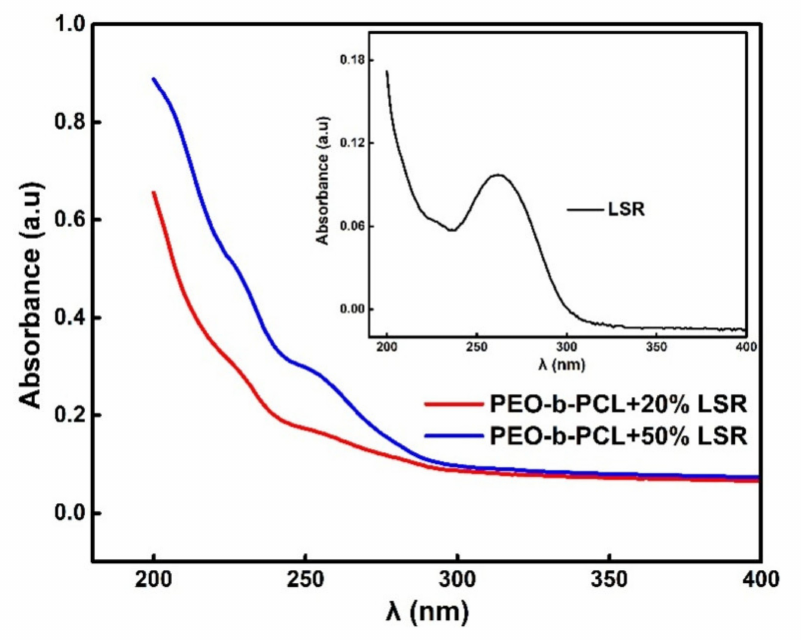
Figure 4. Comparison of UV-Vis spectra for LSR-loaded PEO-b-PCL